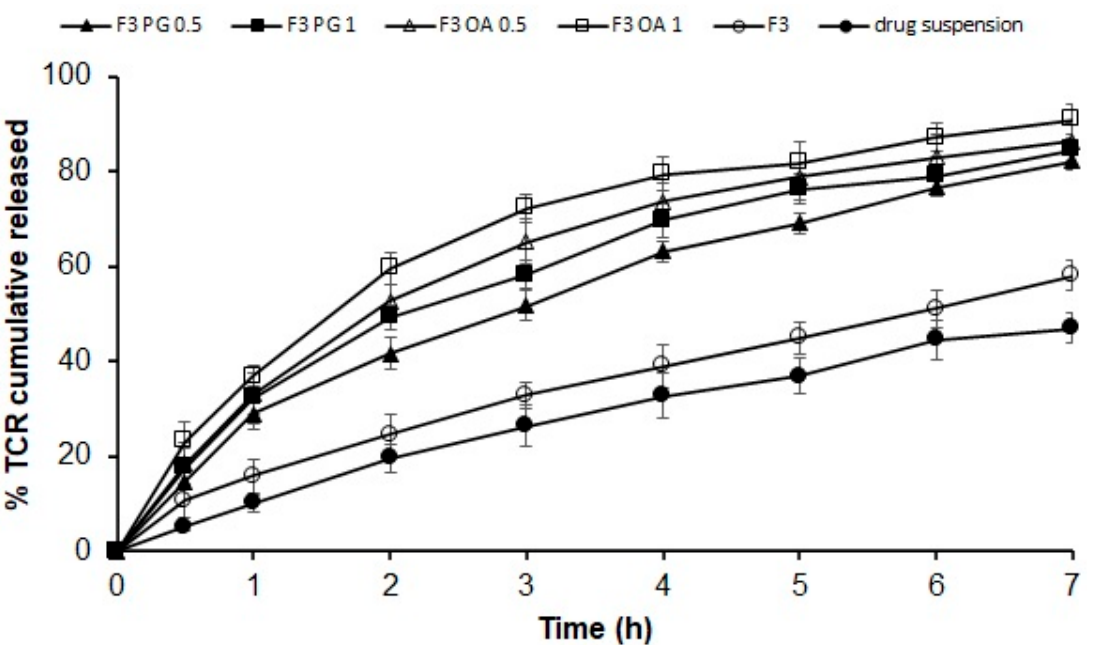
Figure 3. In vitro release data of different permeation enhancers containing TCR-loaded SPLs. Results ( n = 3) are presented as mean ± SD. Table 3. In vitro release, the kinetic parameters and ex vivo permeation of different permeation enhancers containing TCR–SPLs ( n = 3, mean ± SD).